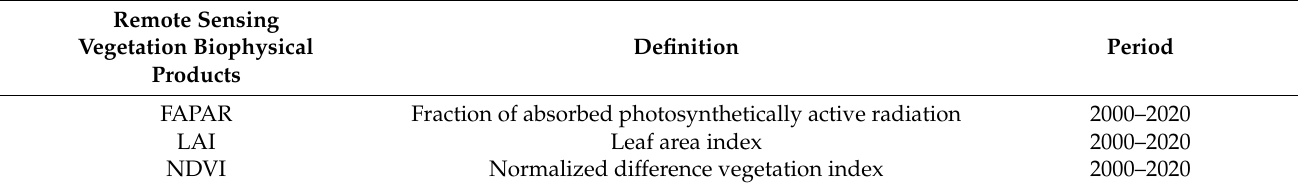
Table 1. Remote sensing vegetation biophysical products used in this study and downloaded from Copernicus Global Land Service (CGLS) (https://land.copernicus.vgt.vito.be/ (accessed on 22 December